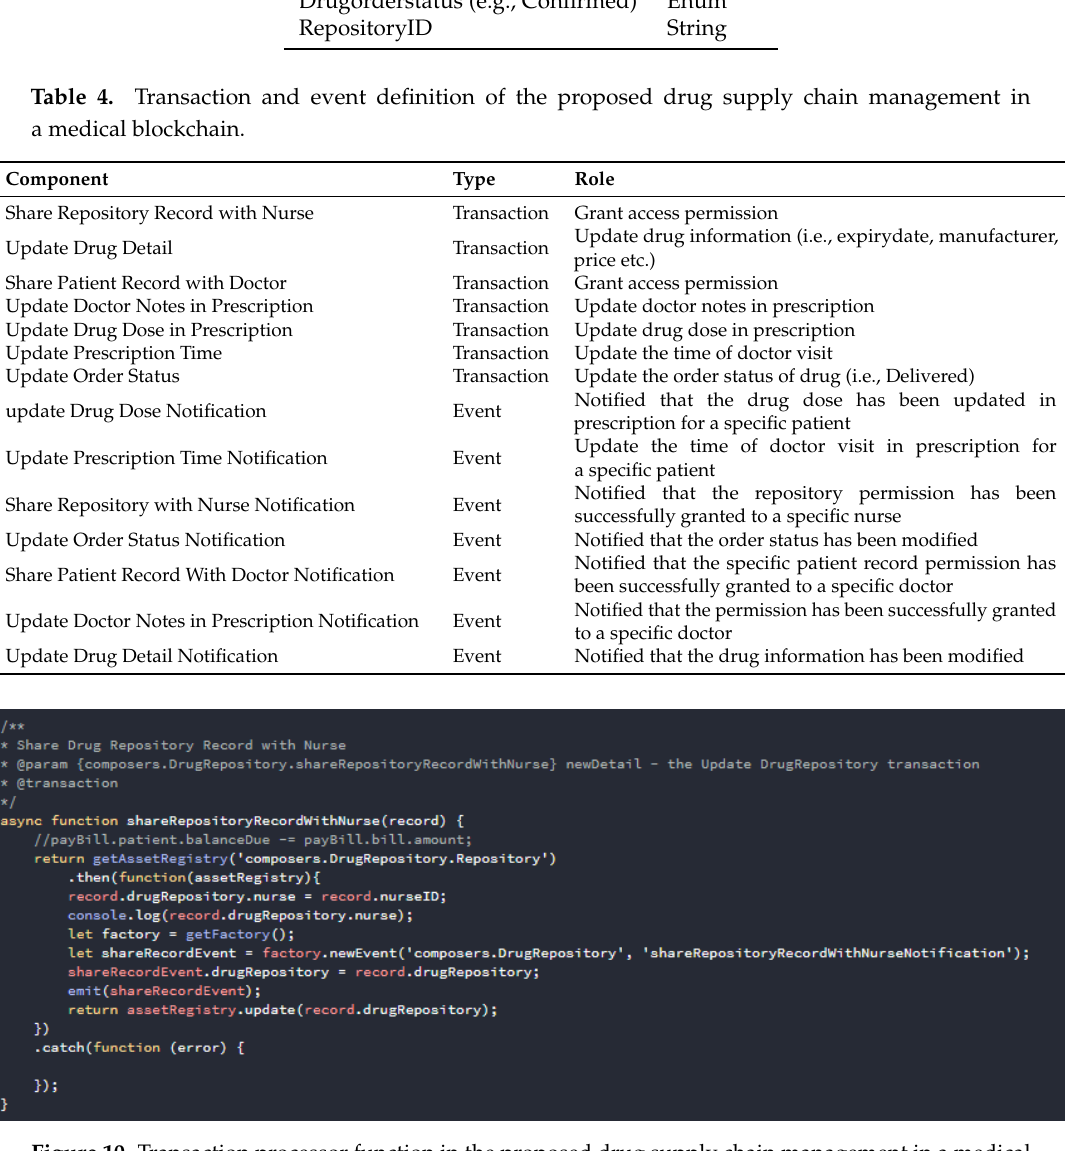
Figure 10. Transaction processor function in the proposed drug supply chain management in a medical blockchain